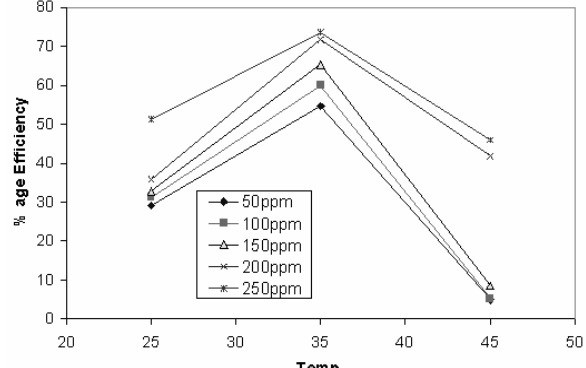
Figure 2 . Variation of percentage inhibition efficiency of SLS with solution